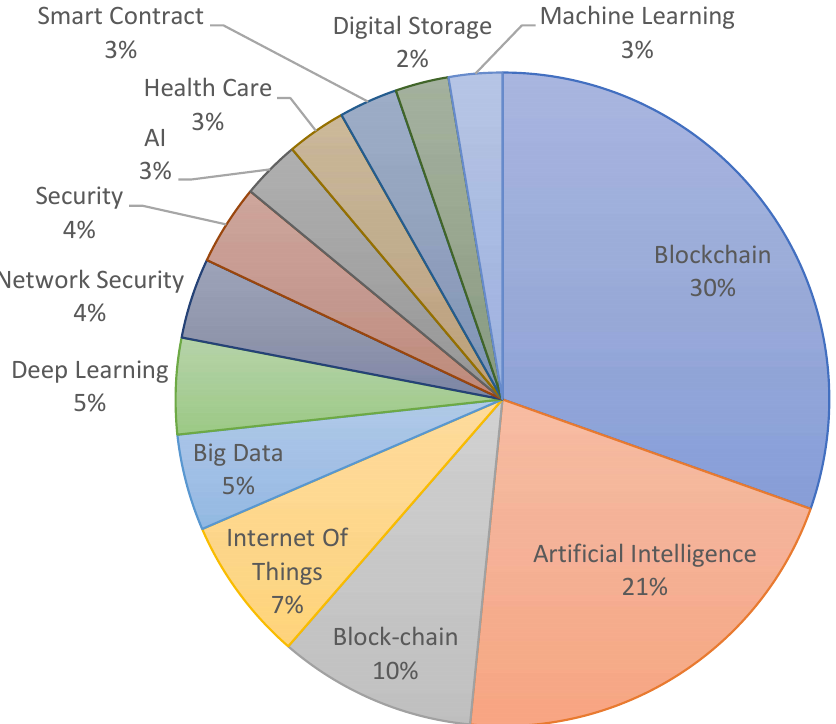
Figure 5. The articles’ primary keywords.